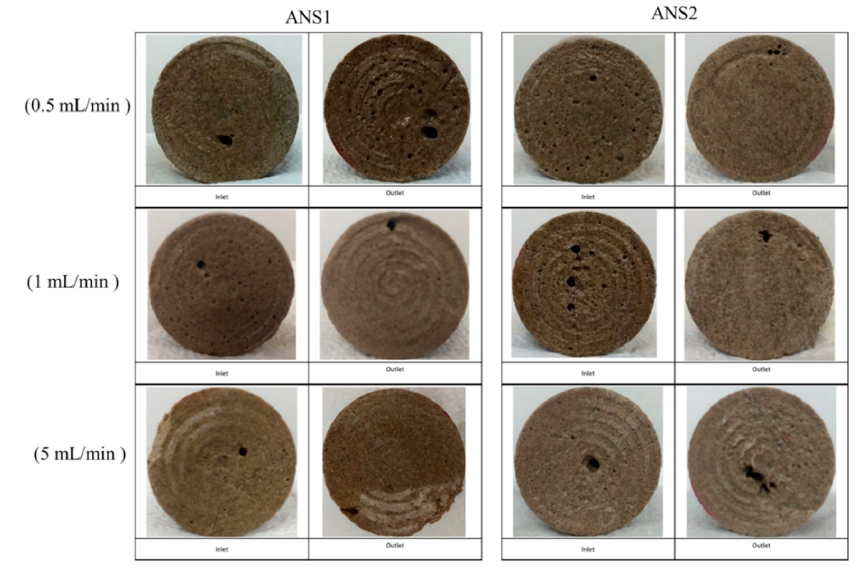
Figure 1. PVBT (pore volume to breakthrough) for ANS1, ANS2, and HCl 15.0 wt. %.